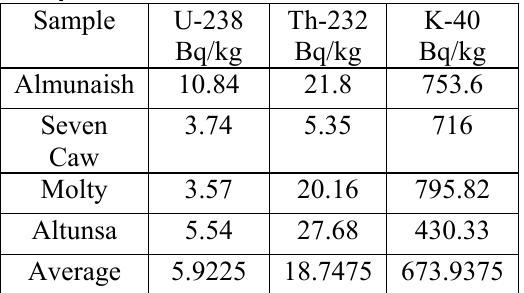
Table 1: The specific activity of U 238 , Th 232 and K 40 in Bq/kg in all powdered milk samples.